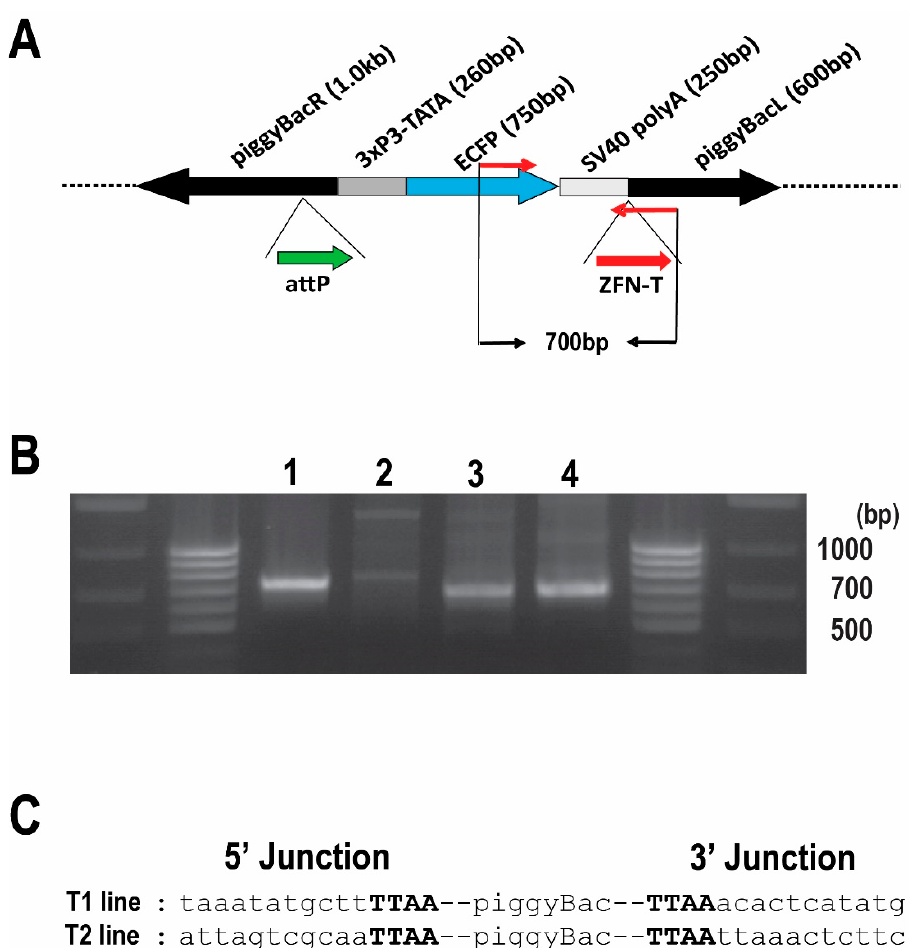
Figure 1. Confirmation of integration into the Bradysia ( Sciara ) genome by piggyBac [3xP3-ECFPafm] attP-ZFN-T. ( A ) Schematic presentation of piggyBac [3xP3-ECFPafm] attP-ZFN-T. The left (L) and right (R) arms of the piggyBac vector are indicated, as is the selectable marker for ECFP driven by the 3XP3 promoter. The target sites for future insertion of large DNA are shown for phiC31 attP (attP, thick green arrow) and for a zinc finger nuclease (ZFN-T, thick red arrow). The PCR primer set to amplify a 700 bp fragment from this vector is indicated by thin red arrows. ( B ) Gel photo of genomic PCR products using internal primer pairs for the vector: (lane 1) Drosophila genomic DNA from larvae transformed with the same vector (positive control); (lane 2) genomic DNA from non-transformed wild type Bradysia ( Sciara ) larvae (negative control); genomic DNA from Bradysia ( Sciara ) transformant line T1 (lane 3) and T2 (lane 4). The 700 bp PCR product is present only in the Drosophila positive control (lane 1) and in the two Bradysia ( Sciara ) transformant lines T1 and T2 (lanes 3 and 4, respectively). ( C ) Sequence of the junction between the transformation vector and genomic DNA recovered from Bradysia ( Sciara ) genomic DNA from transformant lines T1 and T2 after using inverse PCR. The TTAA target site (in bold font) flanking the piggyBac vector is present in both Bradysia ( Sciara ) transformant lines (T1 and